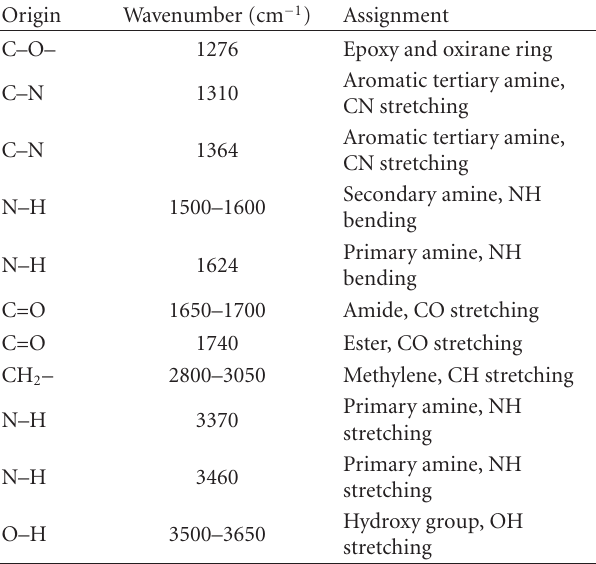
Table 1: Assignment of the absorption bands in the FTIR-ATR spectra (see Figure